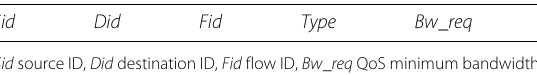
Table 4 The format of QRREP